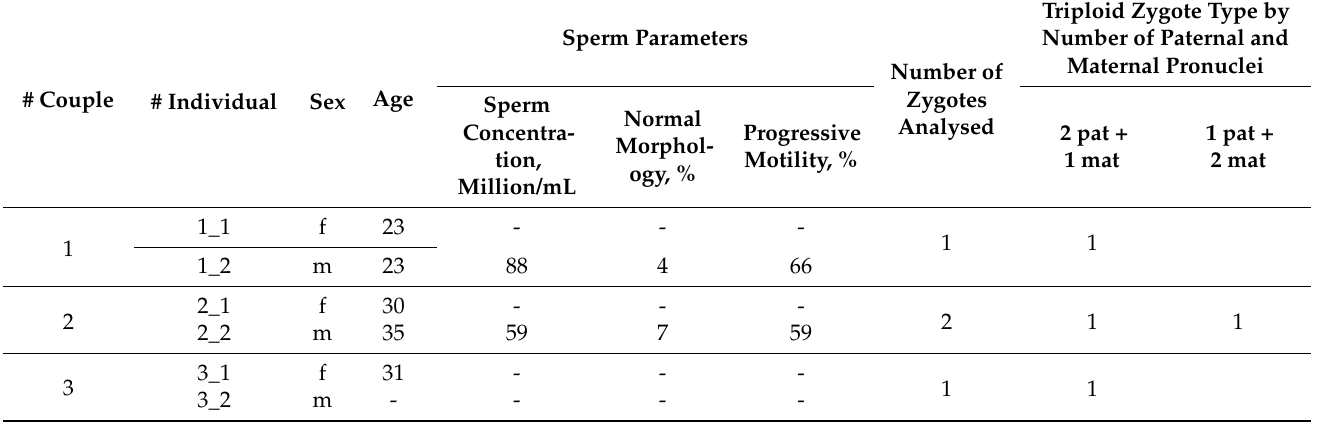
Table 1. Participants’ demographic information, sperm parameters and pronucleus